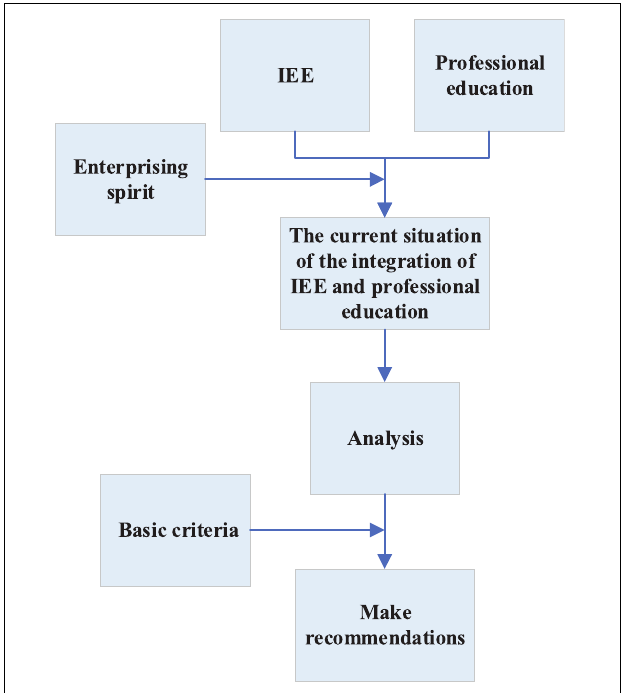
FIGURE 1 | Research